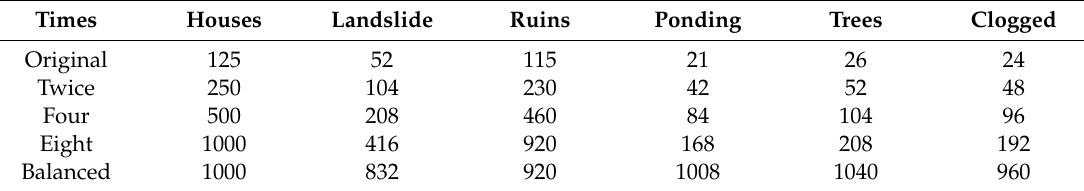
Table 4. Data volume after augmentation and balance. Two times the original number of data is obtained via the mirroring transform, four times via the rotation transform and eight times via the combination of the two transforms. The last row is the data distribution after data